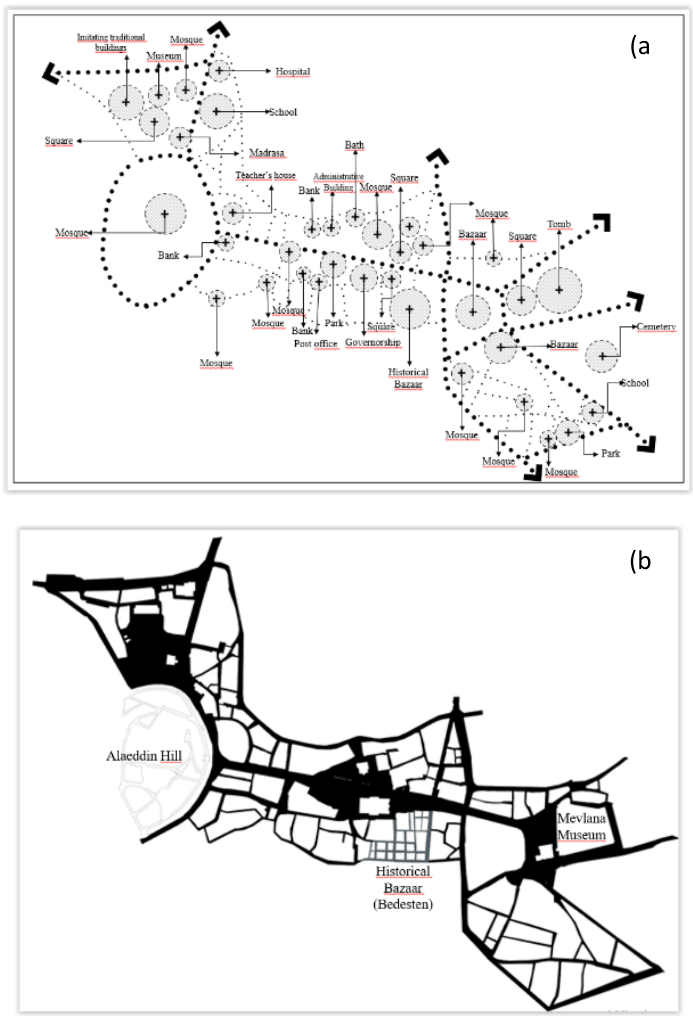
Figure 14 Representation of research area linkages in group form (a) and Linkage analysis of case area in mega form (b) (Ünal,